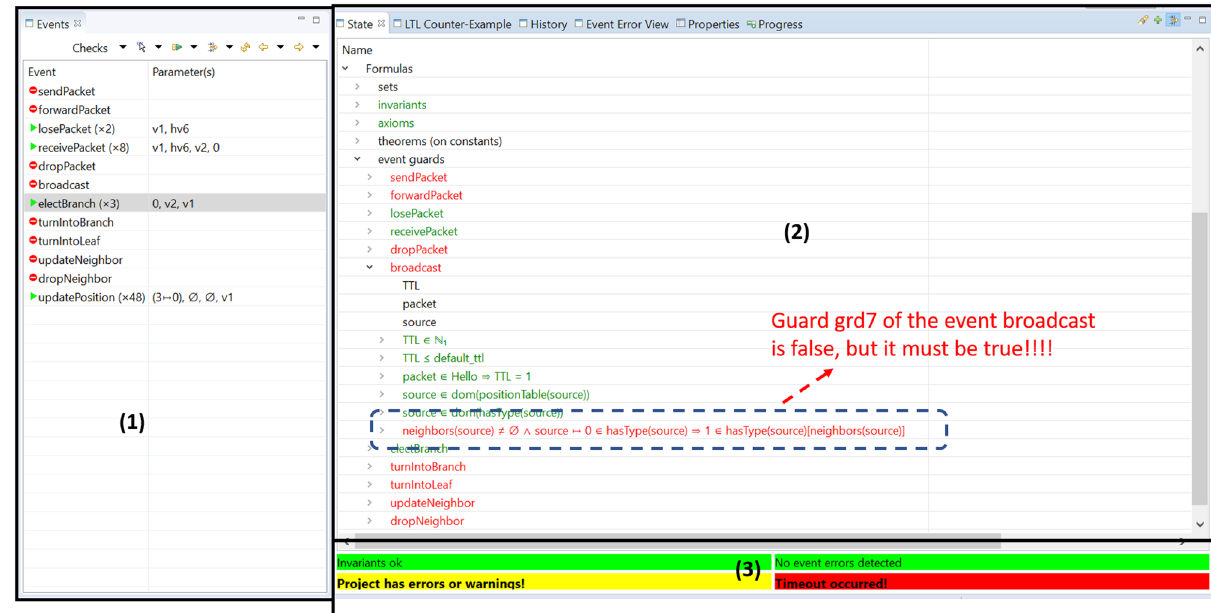
Figure 12. ProB animation window of the CCM 4 CBL